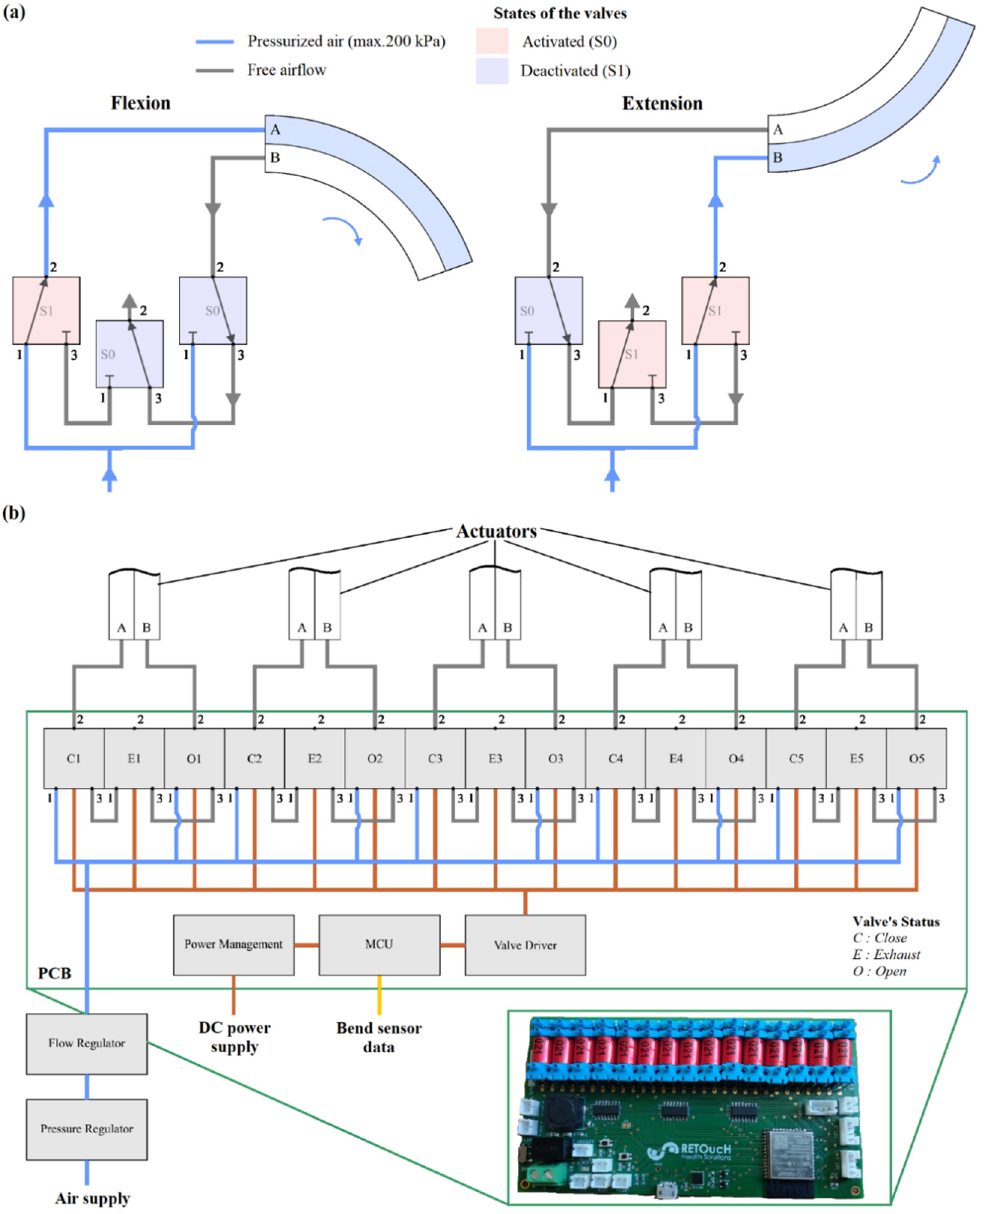
Figure 5. ( a ) Illustration of flexion ( left side ) and extension ( right side ) of a single actuator coupled with the schematic diagram of the pneumatic circuit; ( b ) Overall pneumatic circuit coupled with the PCB configuration.